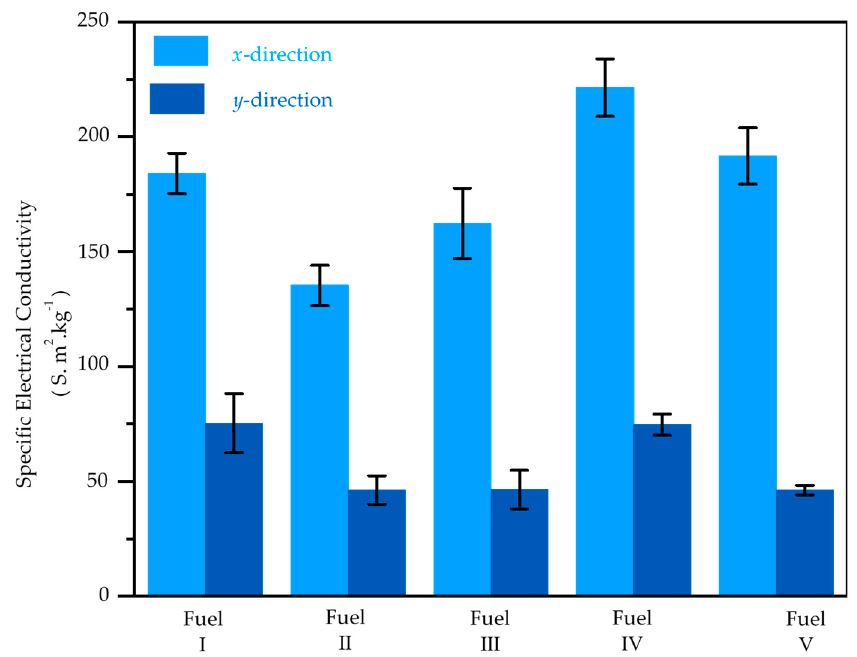
Figure 13 . Specific electrical conductivity of the CNT samples synthesized from five fuels